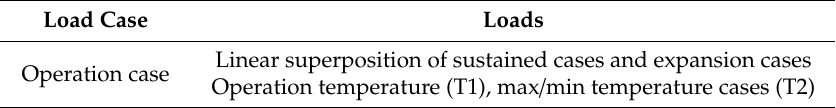
Table 7. Load condition for reaction force and displacement of pipe in